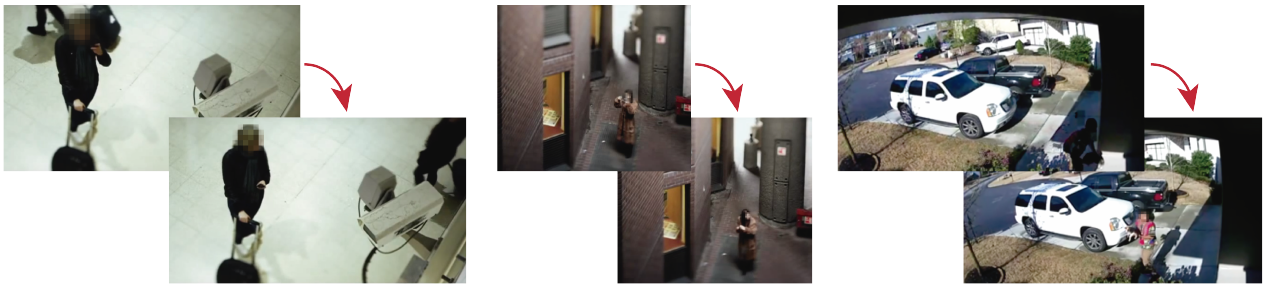
Figure 1. Different situations may be recorded by surveillance cameras. Suspicious behavior is not the crime itself. However, particular situations will make us distrust a person if we consider their behavior to be